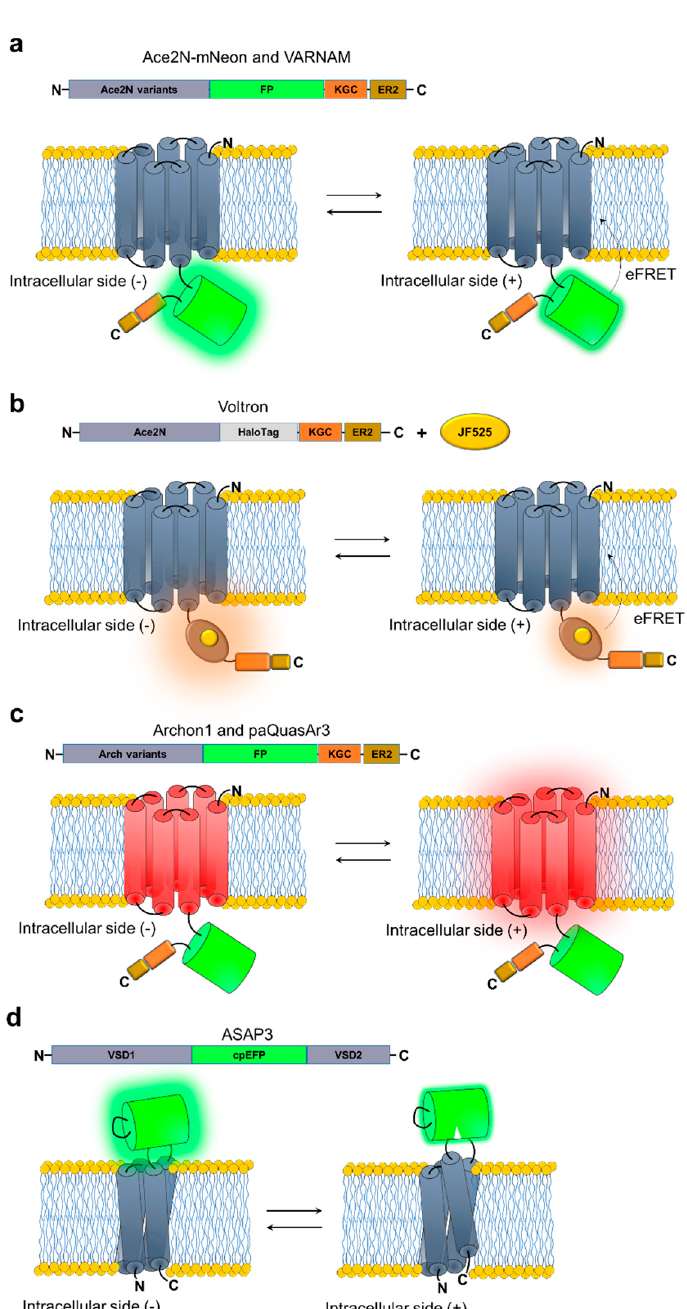
Figure 2. Molecular design of selected genetically-encoded and hybrid fluorescent voltage indicators. (a ) eFRET-opsin voltage sensors Ace2N and VARNAM. ( b ) Hybrid eFRET-opsin voltage sensor Voltron. ( c ) Opsin-based voltage sensors Archon1 and paQuasAr3. ( d ) VSD-based voltage sensor ASAP3.